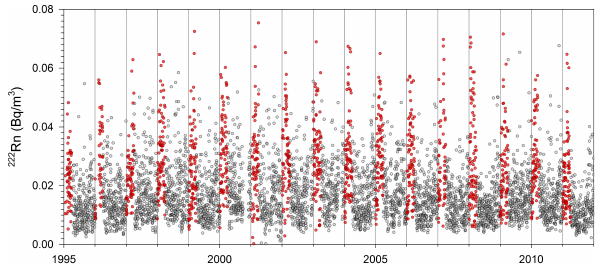
Fig. 2. 222 Rn activity time series based on daily means; red circles refer to summer (JFM) values.